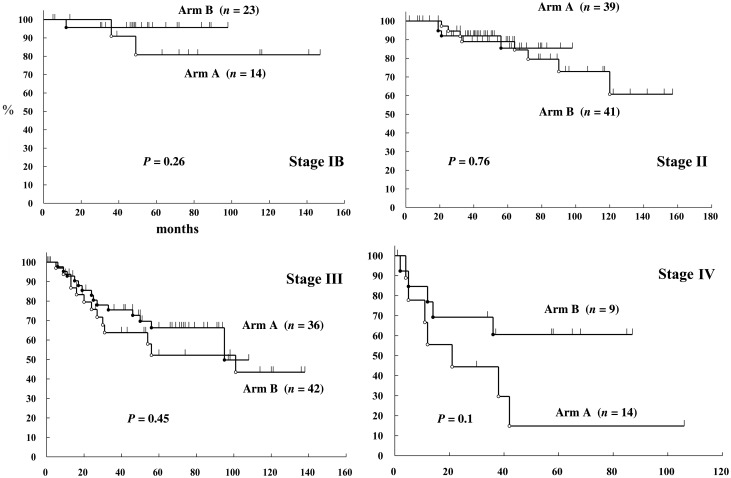
Cause-specific survival of carcinoma of the uterine cervix by treatment schedule (June 1998–December 2009).